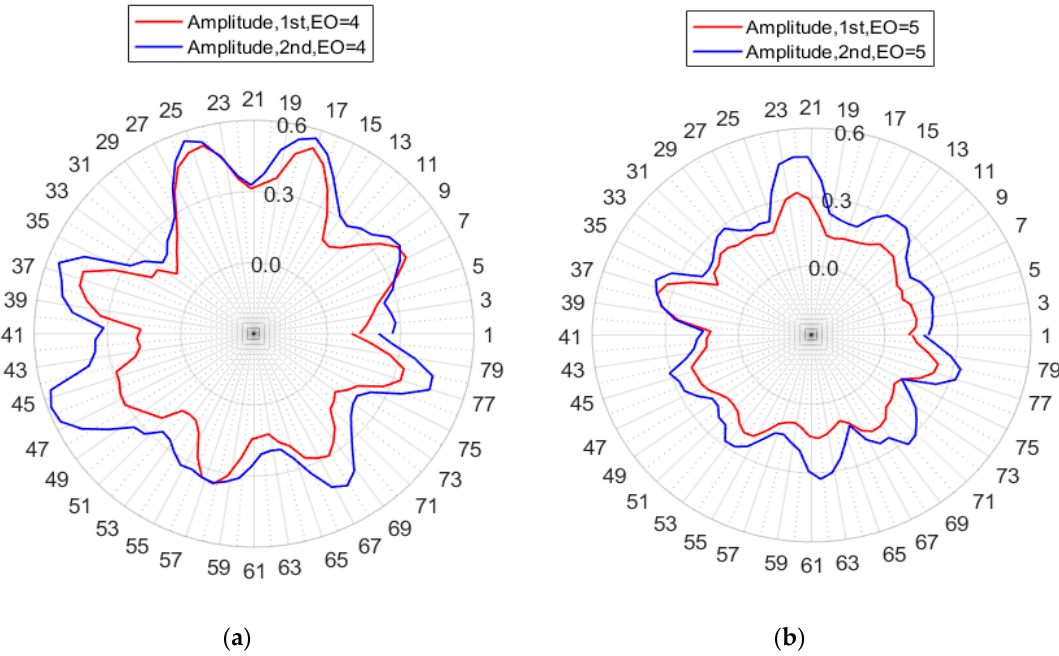
Figure 13. Polar plots of all blade amplitudes: ( a ) EO = 4 and ( b ) EO = 5.